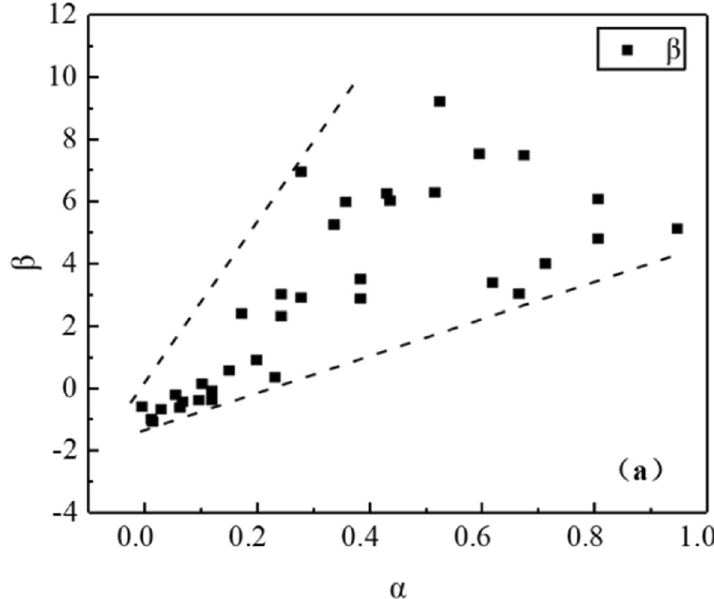
Fig. 12 Distribution of magnetic characteristic index value